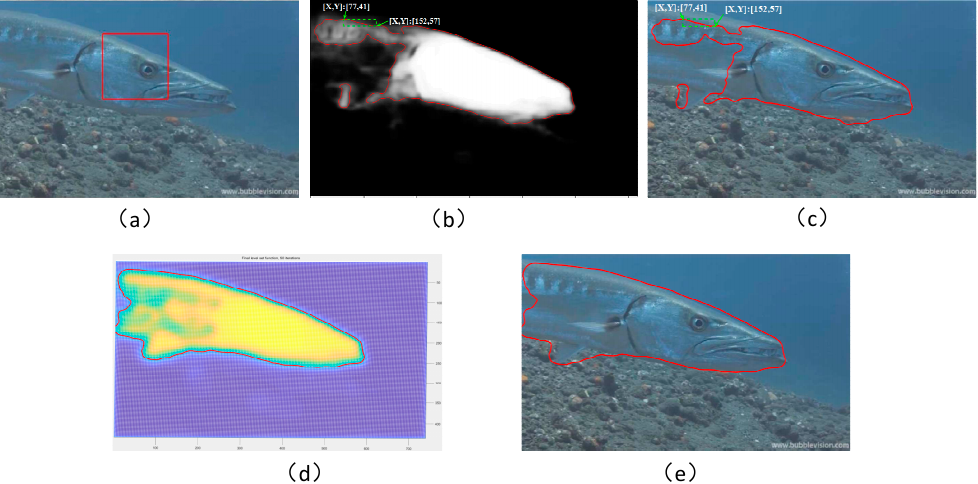
Figure 3. The results of our method. ( a ) The original underwater image with an initial zero level contour. ( b ) the contour extraction result of the saliency target. ( c ) The contour extraction result without correction. ( d ) The final level set function. ( e ) The result of our method.